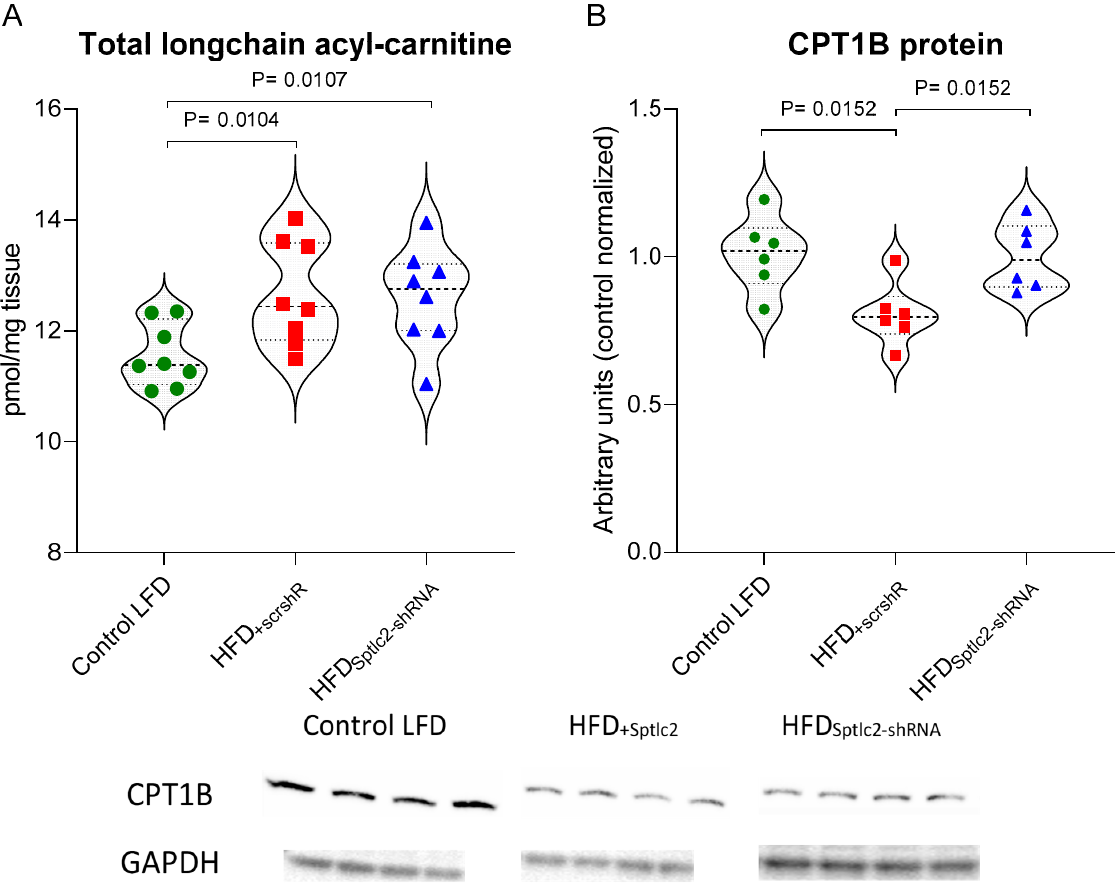
Figure 5. ( A , B ) The impact of skeletal muscle Sptlc2 silencing on the content of acyl-carnitines and the protein expression of CPT1B: ( A ) the content of long-chain acyl-carnitines ( n = 8); ( B ) protein